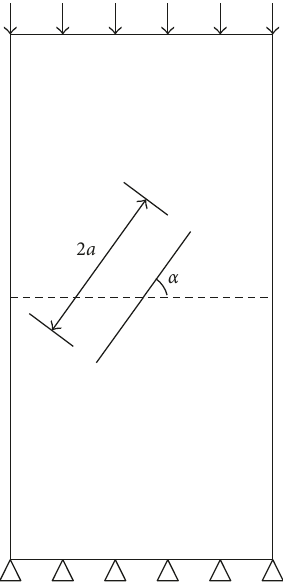
Figure 1: The calculation